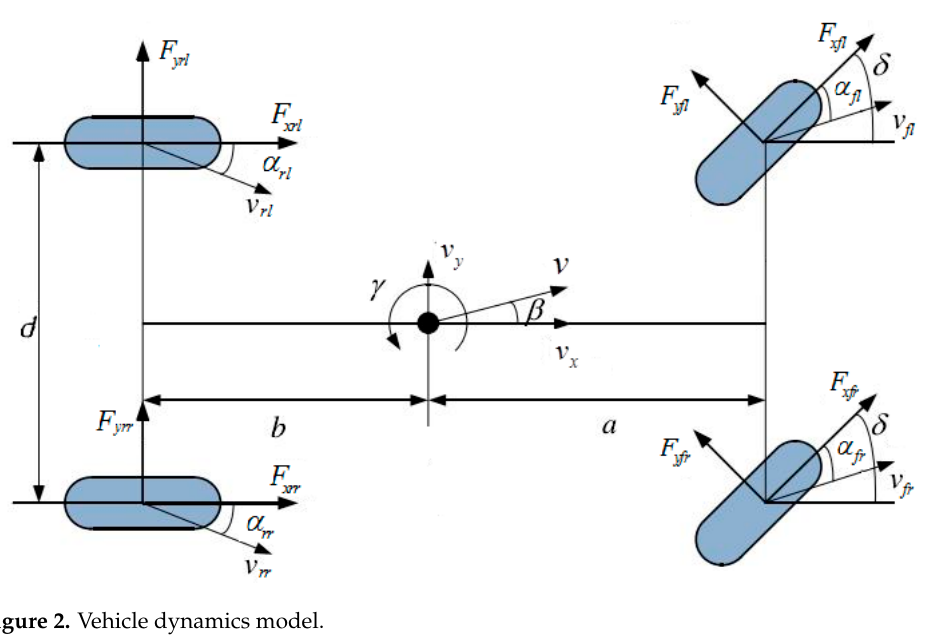
Lateral motion equation of the vehicle: